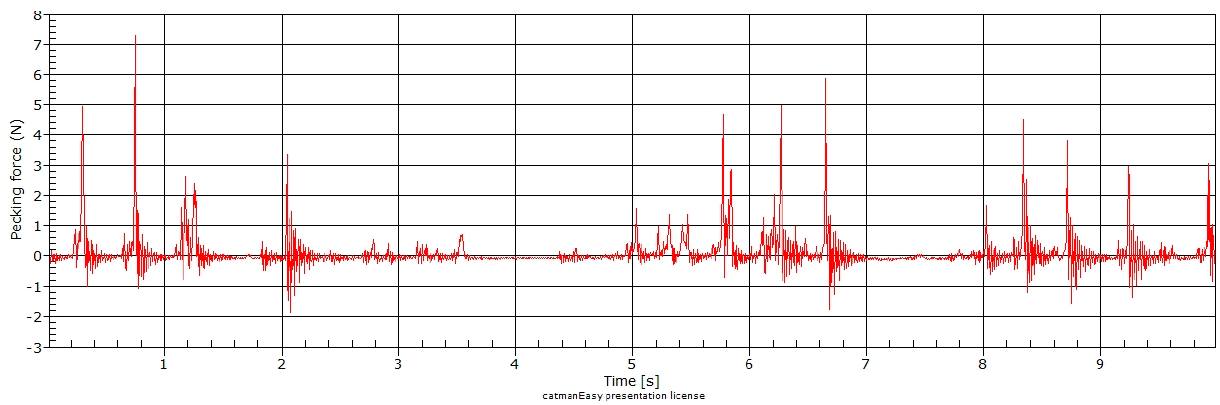
Figure 3. Pecking force at one-minute time length.